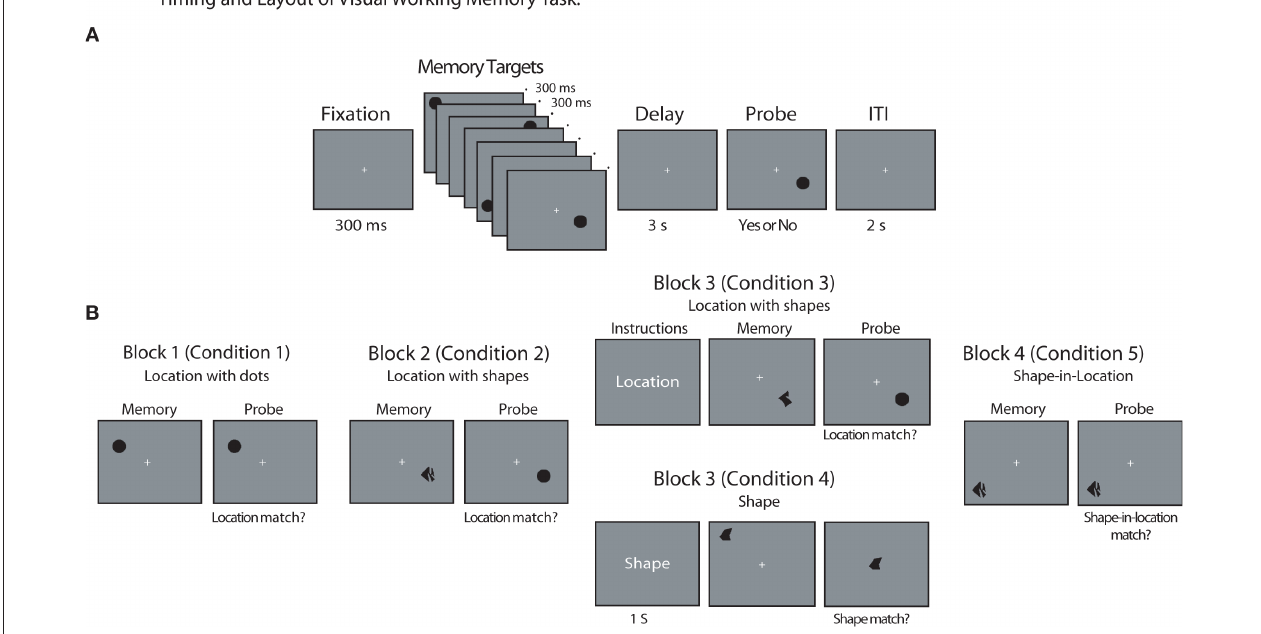
Figure 1 | Behavioral task. (A) General timing of fixation, stimuli, delay period, probe, and ITI used during all task blocks of VSTM task. Note that Block 3 also included an additional 1-s presentation of task instructions at the beginning of each trial. (B) Example memory target and probe item for each task block and condition (in each case, a match trial is depicted). Stimuli are not drawn